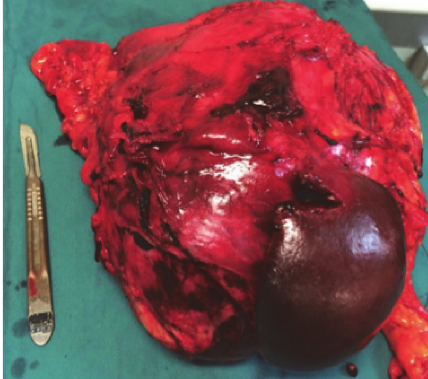
Figure 3: En bloc resection of the left adrenal mass, pancreatic tail, spleen, and left